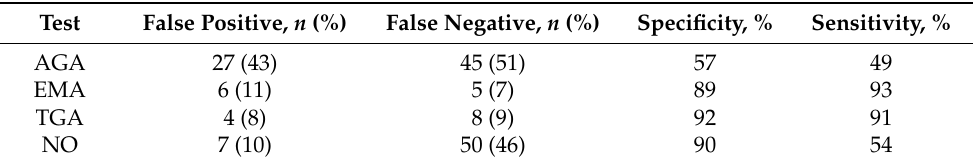
Table 2. Specificity and sensitivity of the different tests used.